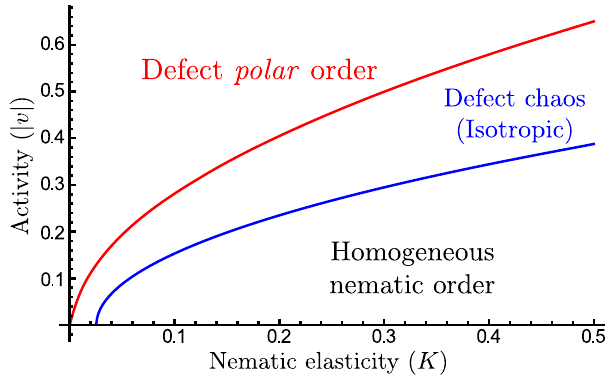
FIG. 6. Phase diagram as a function of activity ( j v j ) and nematic elasticity ( K ). Here, we fix ν ¼ π and γ ¼ 1 and take T ¼ T þ T v 2 , and D ¼ D 0 þ D 1 v 2 , with T =T ¼ 10 − 2 0 1 R 0 1 R R and D 0 R =D 1 R ¼ 10 in units where v 2 0 ¼ D 0 R T 0 = γ ¼ 0 . 1 sets the scale of j v j 2 . The overall topology of this phase diagram does not change for other values of parameters, with the sole exception of T ¼ 0 , T ≠ 0 , in which case the homogeneous nematic phase 0 1 extends all the way down to K ¼ 0